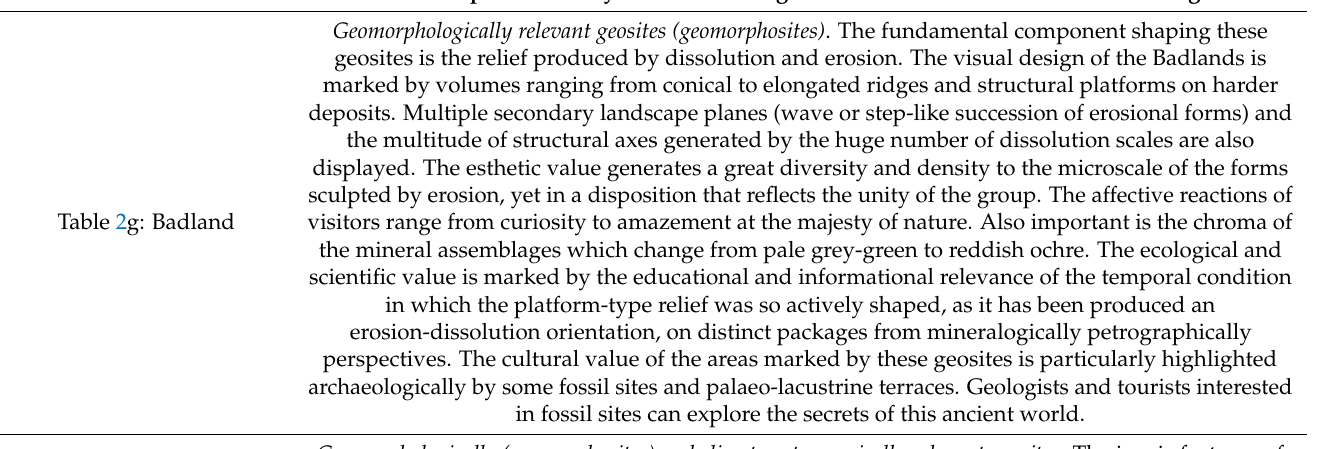
Geomorphologically (geomorphosites) and climate-astronomically relevant geosites. The iconic features of nocturnal landscapes belonging to these geosites are both the sandy-stony surfaces, the prismatic erosion markers, and the nocturnal atmospheric environment marked by particular weather conditions. It is the very clean air that creates a clear atmosphere and perfect visibility for observing celestial bodies. The esthetic value provided by the pleasant dispute between the mineral masses and the sky, between the horizon line belonging to the interfluves and the sky delicately illuminated by the night stars; the dominance of cold tones, without speaking of an anguish atmosphere; the participation of pale light and wispy clouds in the spectacle given by nature.> Starting from